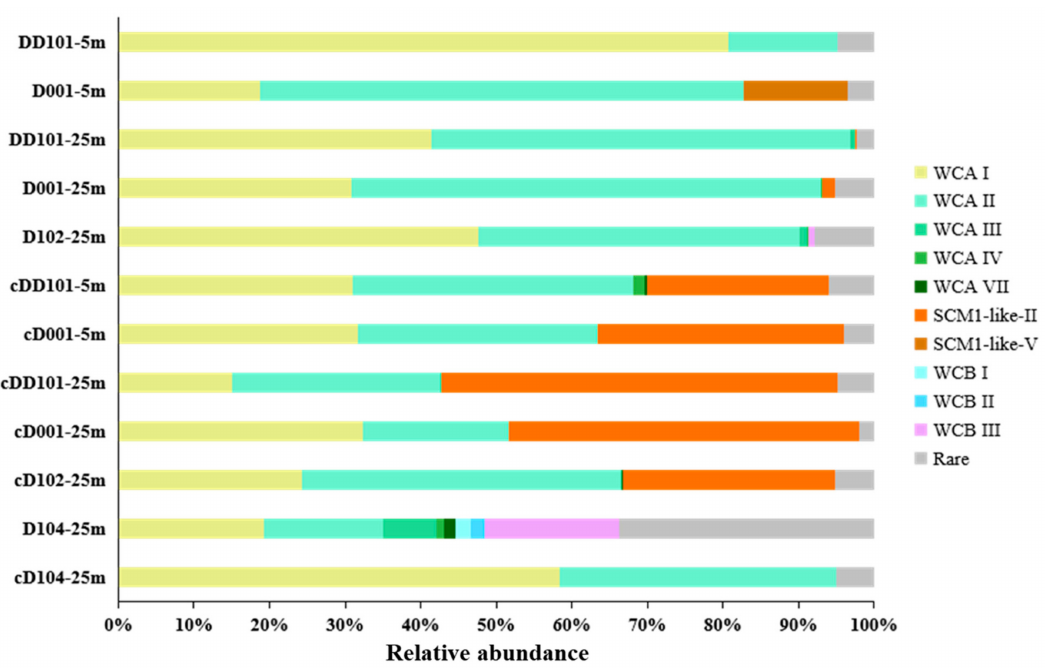
Figure 5. Community structure of AOA at the DNA and cDNA levels for samples collected from different stations in the eastern Hainan Island during summer.